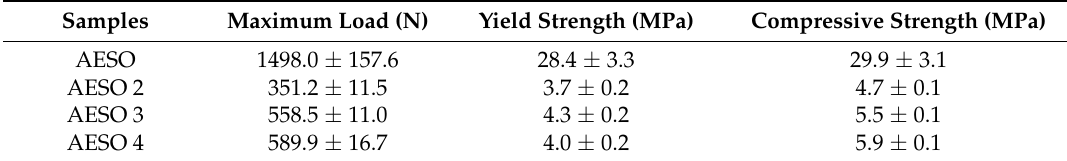
Table 2. Mechanical properties of the pristine AESO and cellulose-reinforced AESO foams.